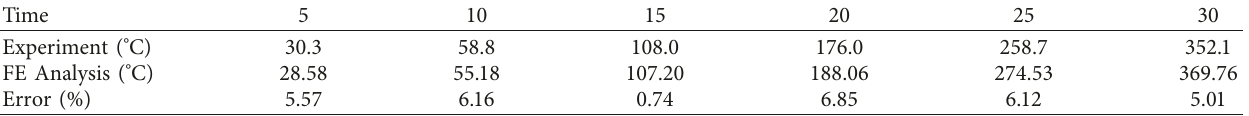
Table 2: Comparison between experiment and numerical analysis for the honeycomb cell.